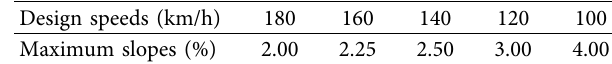
Table 6: Maximum slope of superhighways (unit: %).